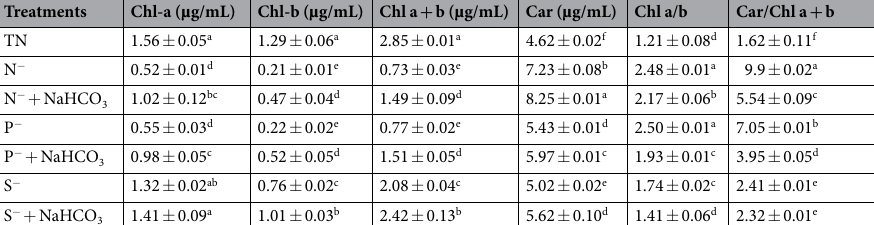
Table 1. Effect of bicarbonate on photosynthetic pigments of D. salina under nutrient deficit conditions. All values are expressed as Mean ± SD (n = 3). Values with different letters represent significantly differ at p < 0.05 between the groups. Total Nutrient (TN); Nitrate deficit (N − ); Nitrate deficit with bicarbonate (N − + NaHCO 3 ); Phosphate deficit (P − ); Phosphate deficit with bicarbonate (P − + NaHCO 3 ); Sulphate deficit (S − ); Sulphate deficit with bicarbonate (S − + NaHCO 3 ). Chlorophyll a (Chl-a); Chlorophyll b (Chl-b); Chlorophyll a + b (Chl a + b); Carotenoid (Car); Chlorophyll a/b (Chl a/b); Carotenoid/Chlorophyll a + b (Car/Chl a +